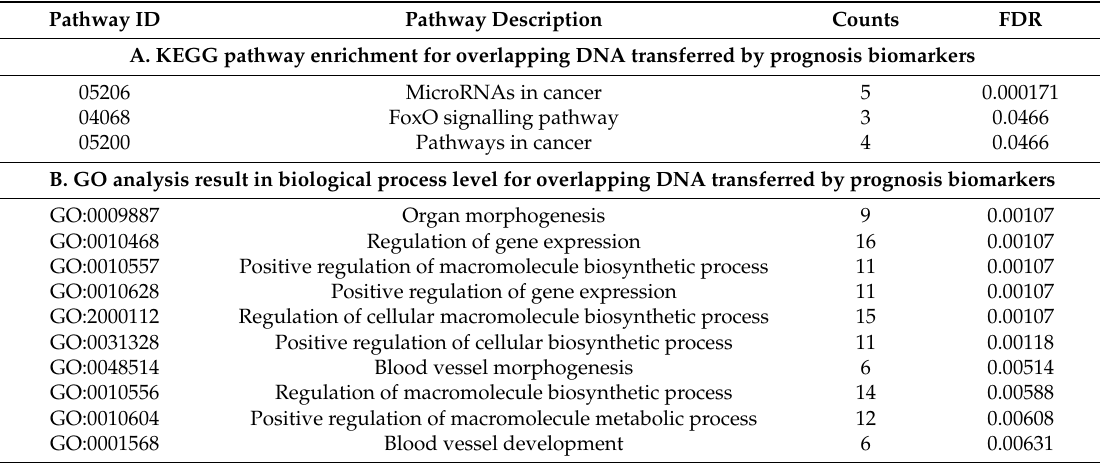
Table 5. Biological functional analysis for overlapping DNA transferred by prognosis biomarkers.